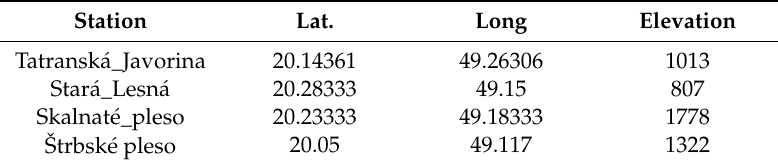
Table 1. Locations of meteorological stations inside our study